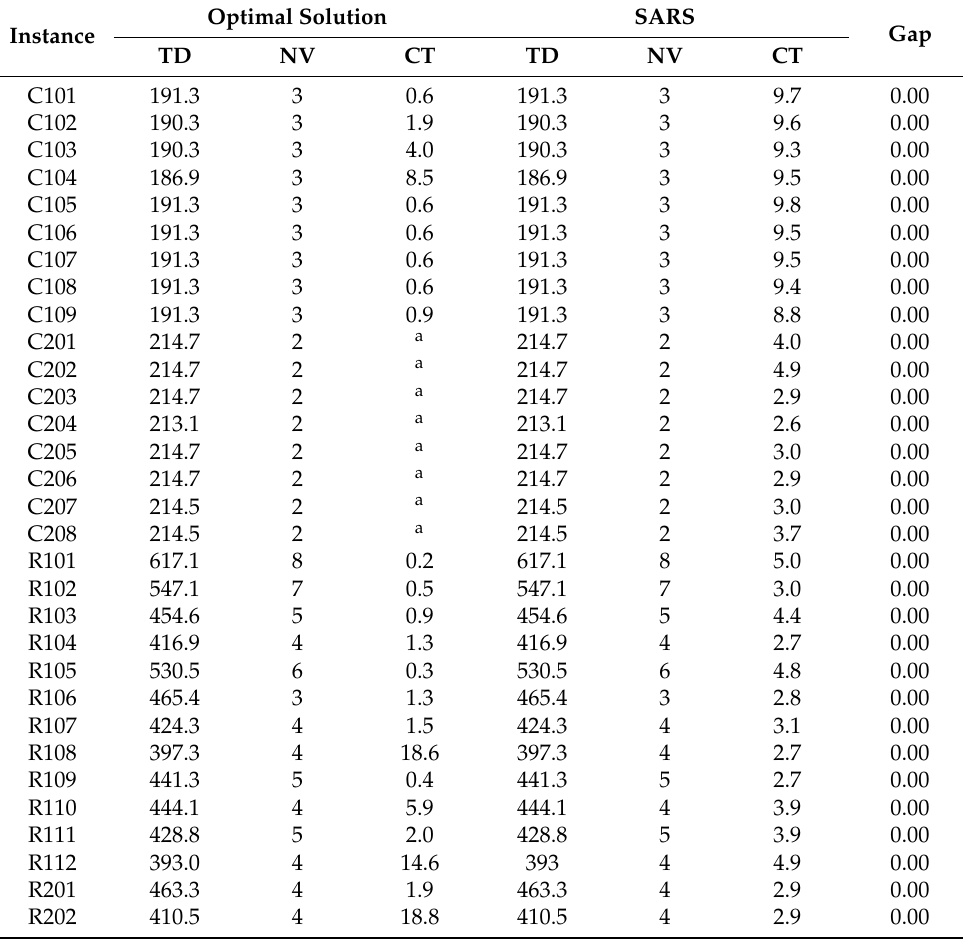
Table 5. Comparison of SARS with other optimal solution heuristics on the VRPTW dataset with 25